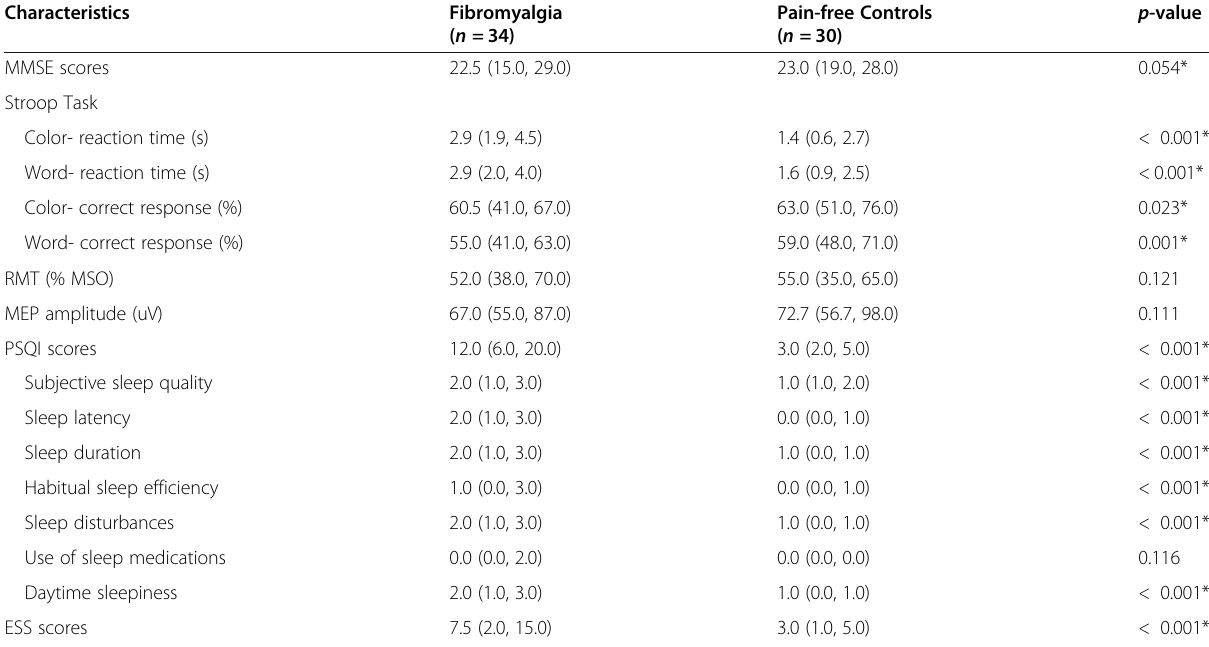
Table 2 Parameters of cognition, corticomotor excitability, and sleep parameters compared between participants with fibromyalgia and